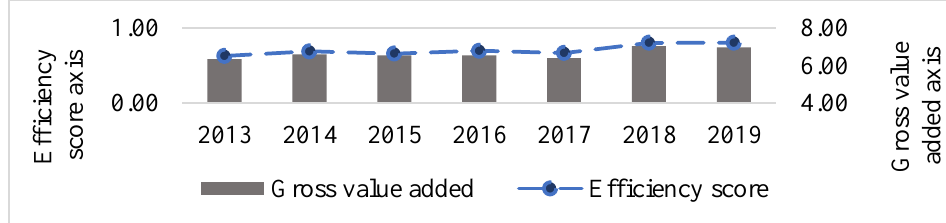
Figure 3. Gross value added (ln) and DEA- based efficiency score. Source: authors’ projection.